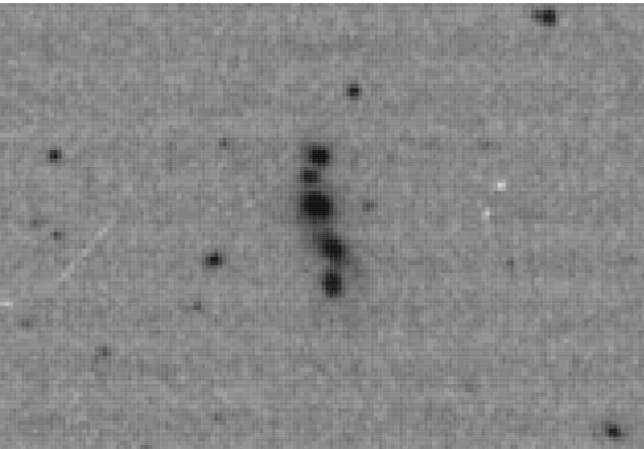
Figure 1. The highly unusual dynamical configuration and small size of HCG 55 appears to be a pre-merger stage.